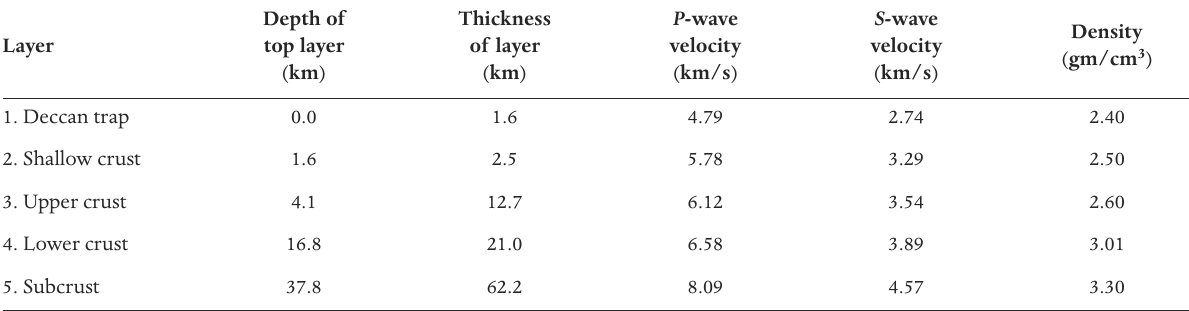
Table 3. The crust and subcrustal structure for northwestern DVP down to 100 km [Prajapati et al. 2011]. Below 100 km the structure is same as that of IP11 [Bhattacharya 1981].